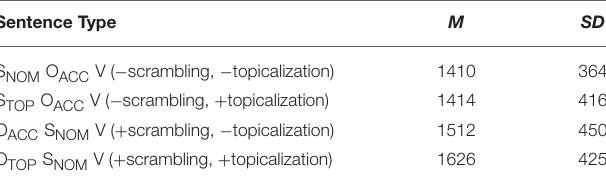
TABLE 2 | Reaction times (ms) for target